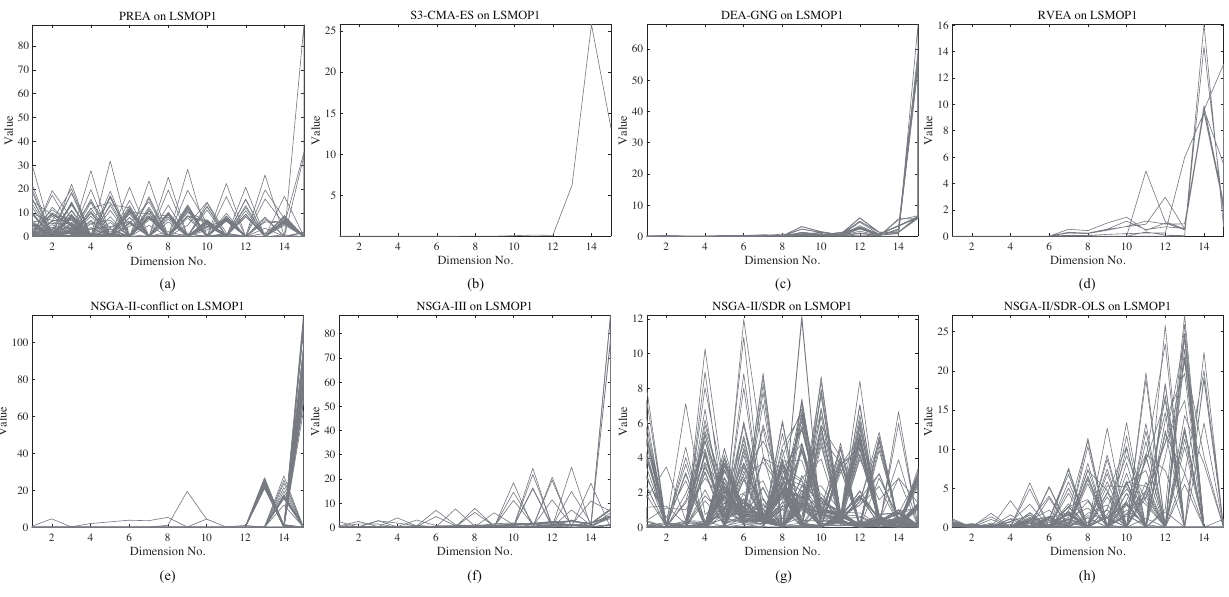
Figure 4. The final solution set obtained by NSGA-II/SDR-OLS and other seven algorithms on 15-objective LSMOP1. ( a ) The final solution set of PREA; ( b ) The final solution set of S3-CMA-ES; ( c ) The final solution set of DEA-GNG; ( d ) The final solution set of RVEA; ( e ) The final solution set of NSGA-II-conflict; ( f ) The final solution set of NSGA-III; ( g ) The final solution set of NSGA-II/SDR; ( h ) The final solution set of